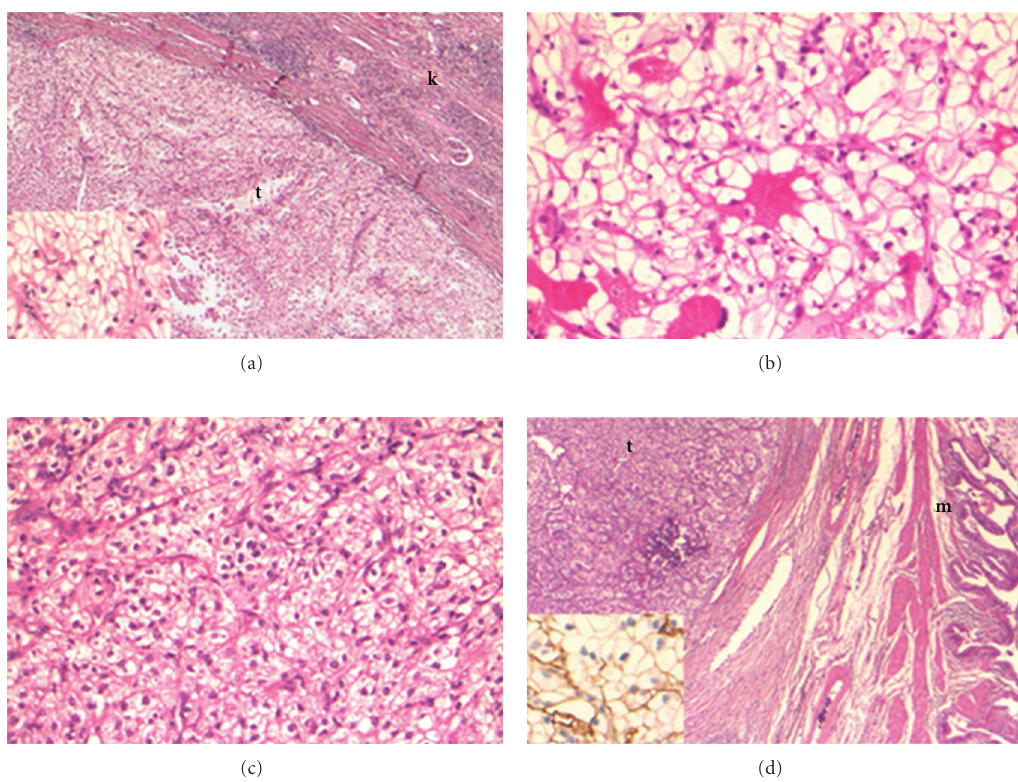
Figure 1: (a) Primary renal cell carcinoma (clear cell type) in the kidney. The tumor (t) is sharply demarcated from the renal parenchyma (k). The tumor consists of sheets of large epithelial cells with an optically empty cytoplasm and sharp cell borders (inset). (original magnification 25x and 200x (inset); Hematoxylin Eosin stain), (b) Metastasis of clear cell carcinoma in the oscalcaneum. Note the similar cell type in metastasis and primary tumor (original magnification 200x; Hematoxylin Eosin stain). (c) Ovarian metastasis of clear cell carcinoma. Note the similar cell type in metastasis and primary tumor (original magnification 200x; Hematoxylin Eosin stain). (d) Metastasis of clear cell carcinoma in the gallbladder. The tumor (t) is located deep in the cholecystic wall (m: mucosa) (original magnification 25x; Hematoxylin Eosin stain). Inset: the tumor cells show the typical membranous staining pattern for CD10, consistent with the immunophenotype of a clear cell RCC (original magnification 200x; immunohistochemical CD10 stain).